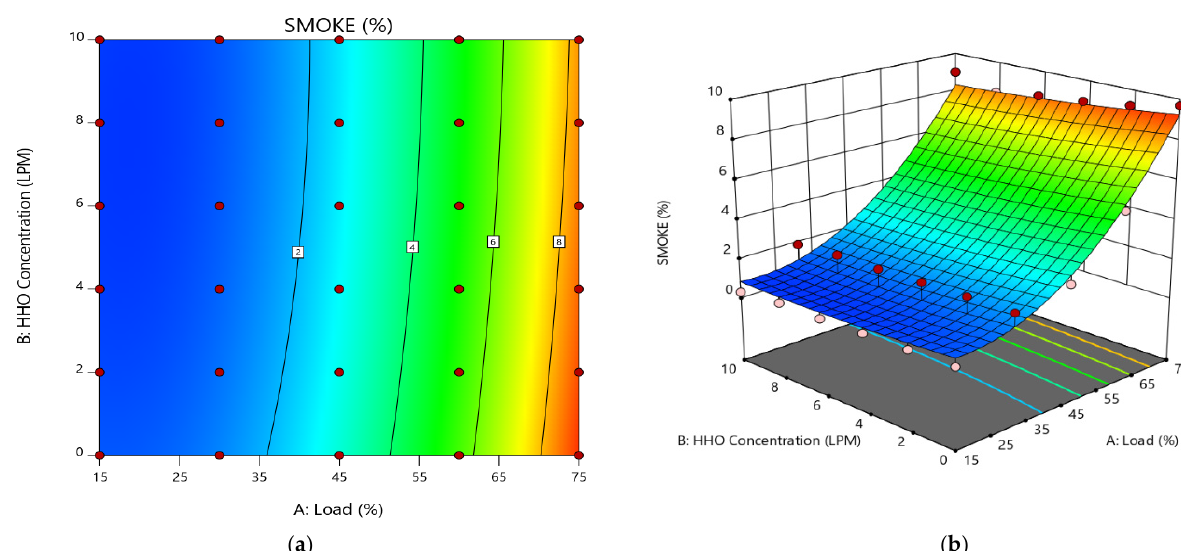
Figure 13. ( a ) Contour plot and ( b ) response surface of